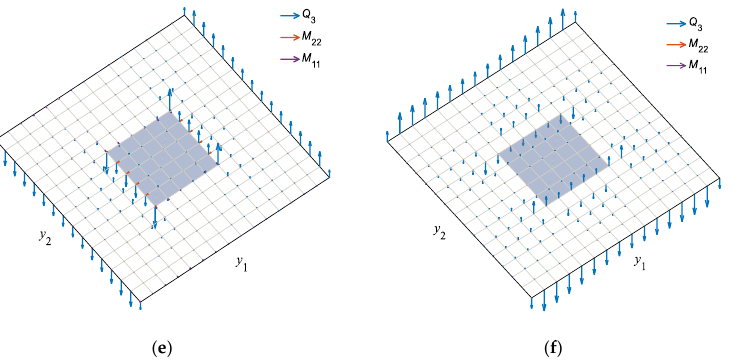
Figure 7. Diagrams of the six columns of 𝑭 3 for the unit cell with single inclusion. (𝐚) 𝑚𝑛𝑝 = 111 ; (𝐛) 𝑚𝑛𝑝 = 221 ; (𝐜) 𝑚𝑛𝑝 = 121 ; (𝐝) 𝑚𝑛𝑝 = 112 ; (𝐞) 𝑚𝑛𝑝 = 222 ; (𝐟) 𝑚𝑛𝑝 = 122 .